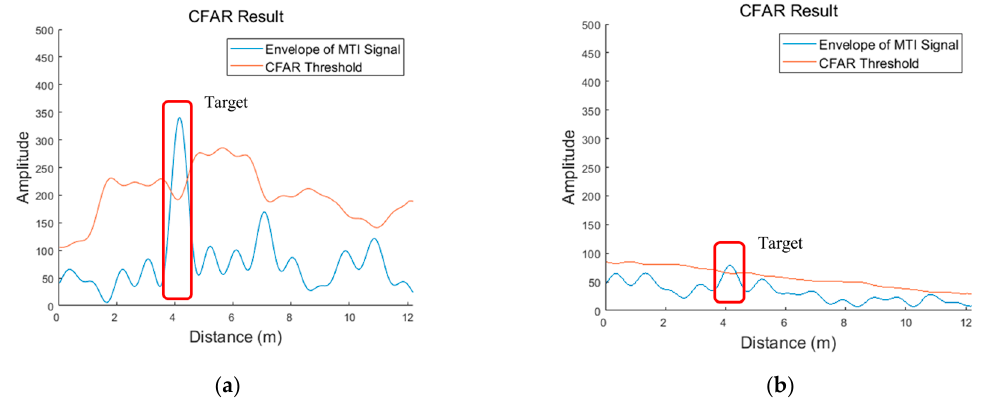
Figure 6. Radar signals at the detection stage: ( a ) constant false alarm rate (CFAR) result with no wall; ( b ) CFAR result through the wall.